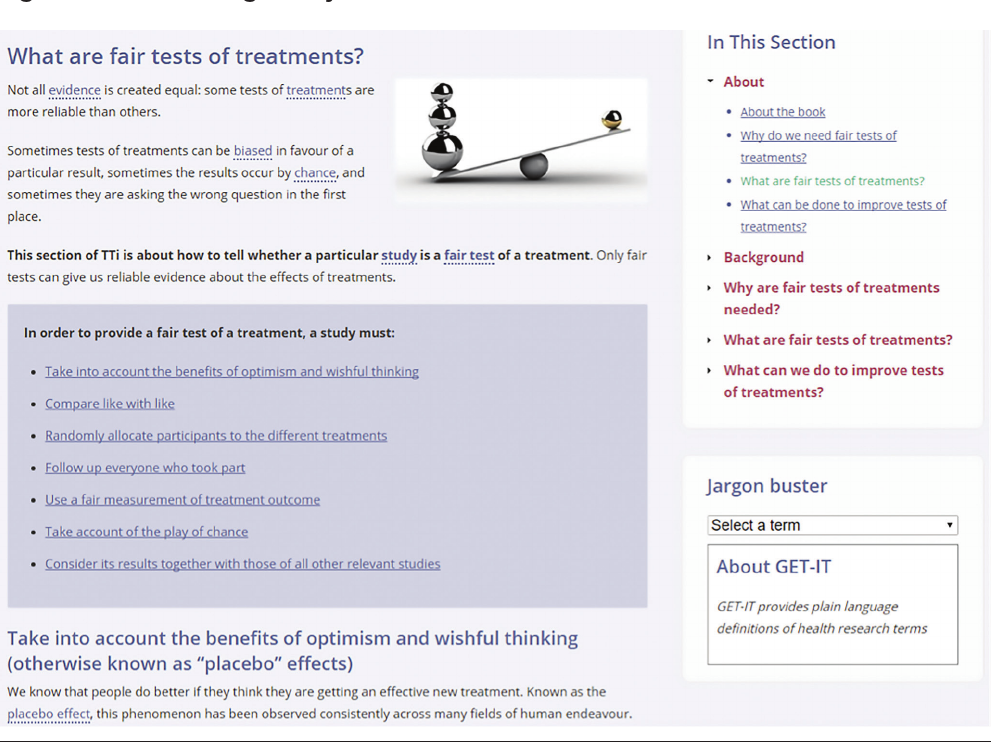
Figure 3: The GET-IT glossary embedded in a